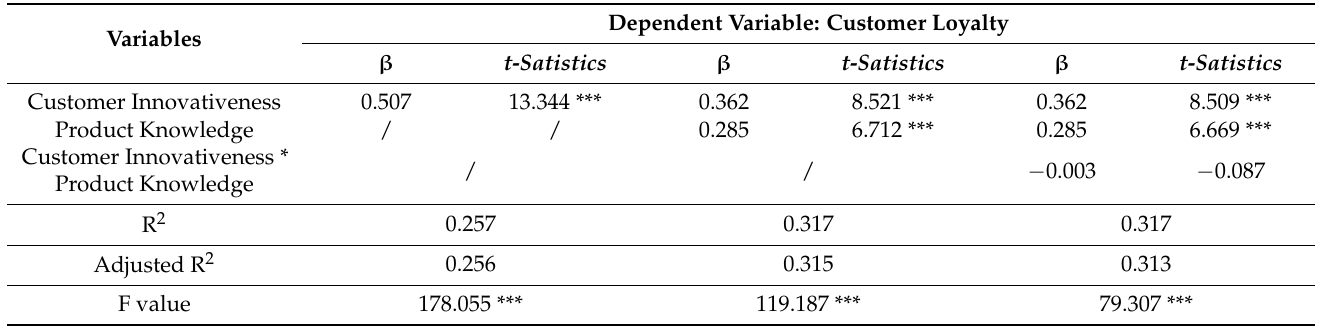
Table 6. Structural model II of the moderating effect from product